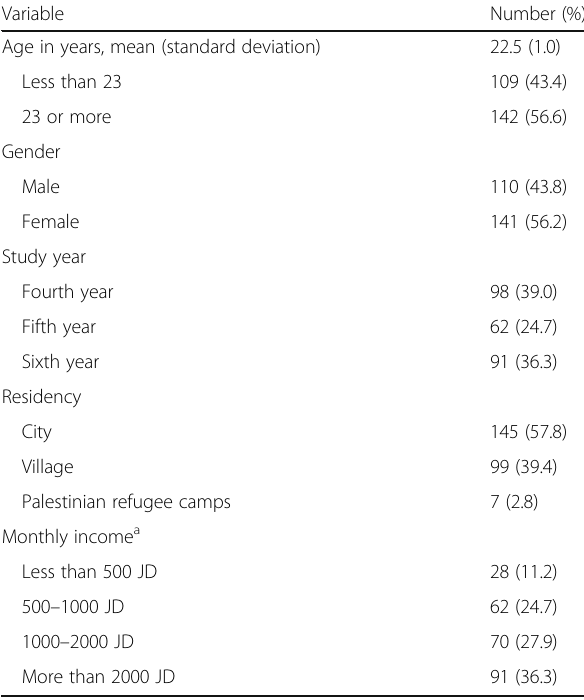
Table 1 Demographic characteristic of the